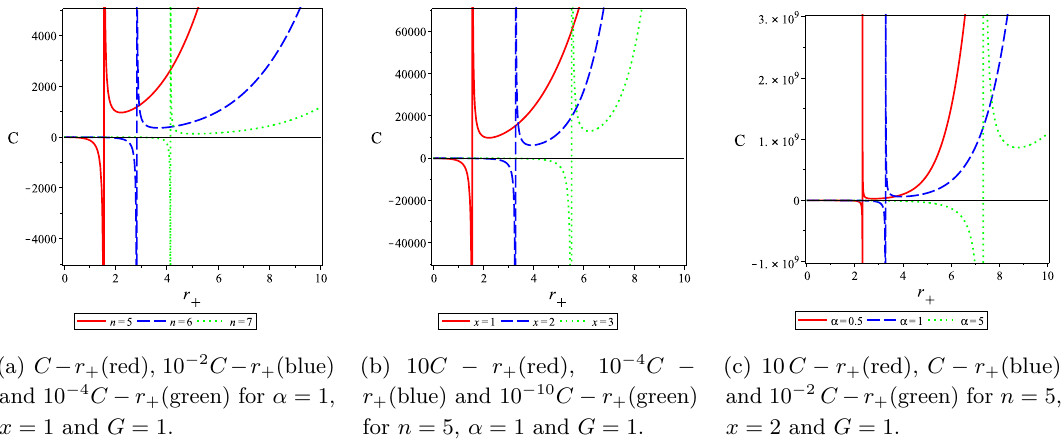
Figure 7 . Behavior of the heat capacity versus r + for k = 1 for “ − ” sign